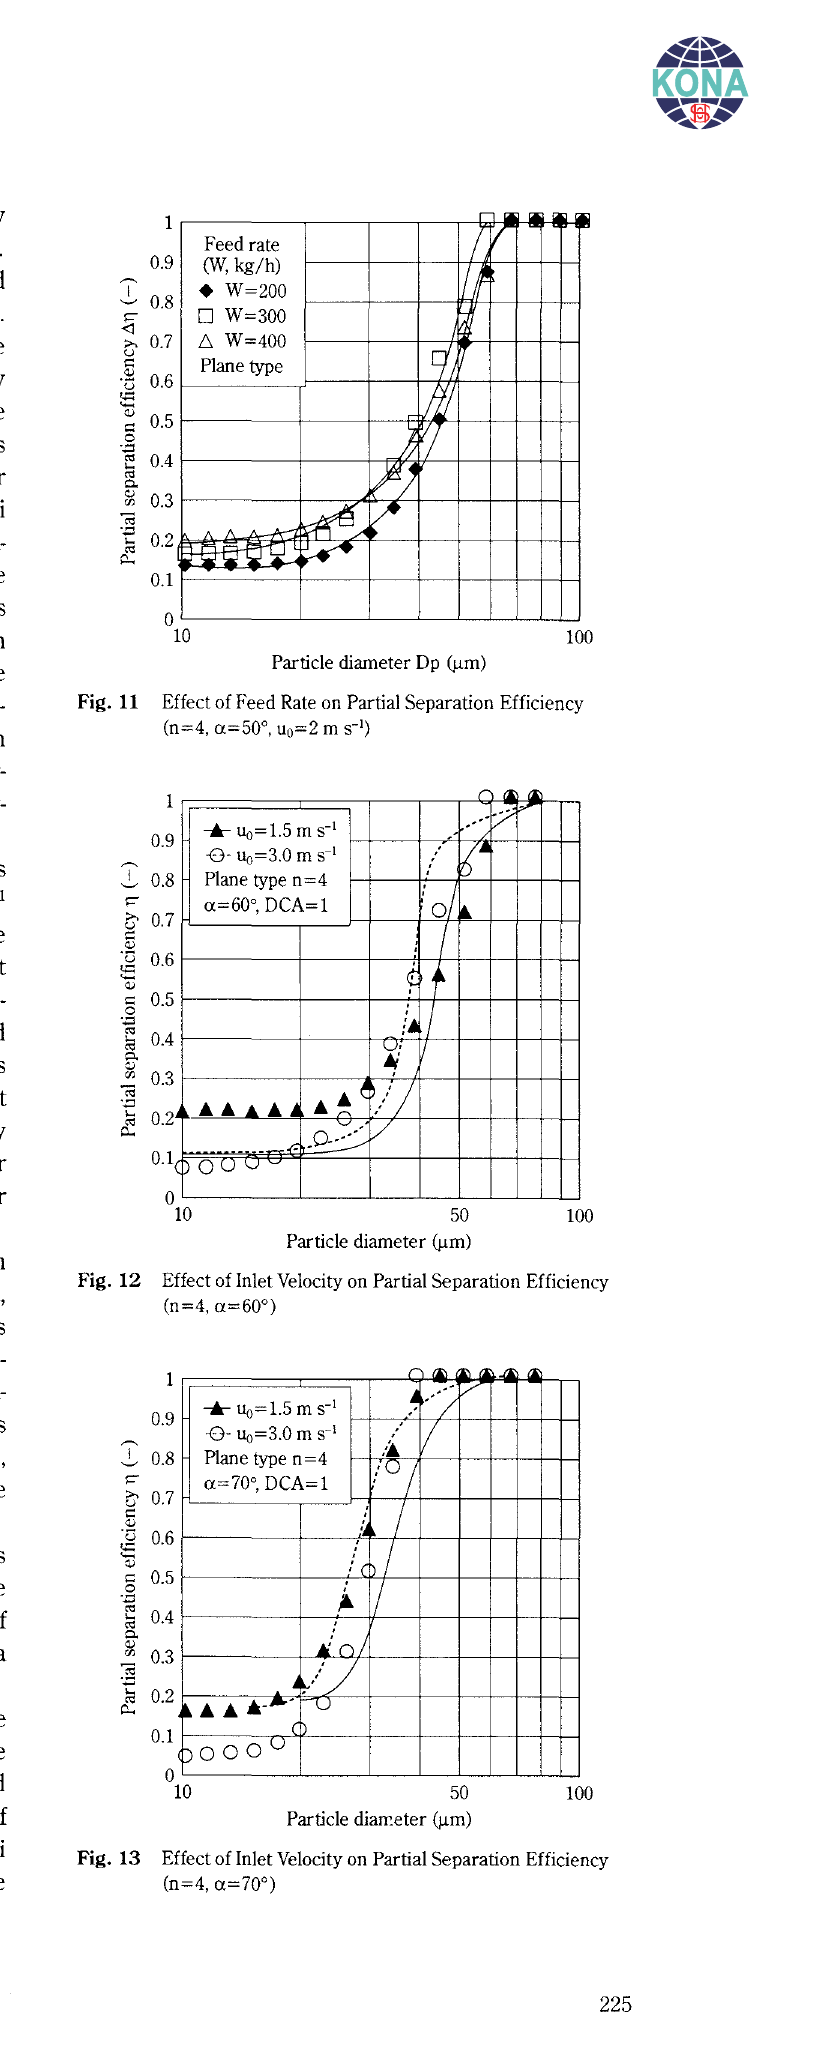
Fig. 13 Effect of Inlet Velocity on Partial Separation Efficiency (n=4,